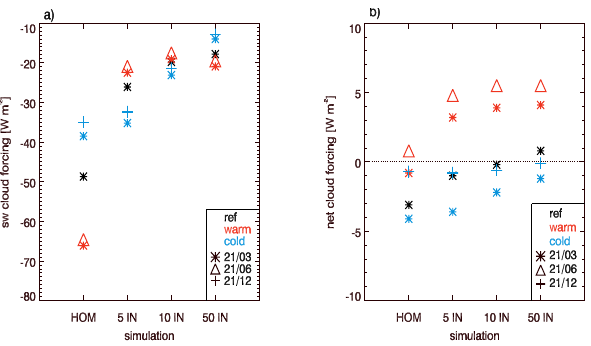
Figure 11. Averaged shortwave cloud forcing (a) and net cloud forcing (b) for the simulations HOM, 5 IN, 10 IN and 50 IN. Black, red and blue asterisks show the results for the reference, warm and cold temperature profiles for 06:00–12:00LT for the simulation where the IN freeze at RHi het = 130% and the solar zenith angle is representative of 21 March. Additionally, the results where the solar zenith angel is representative of 21 June (21 December) are shown for the warm (cold) profile for 06:00–12:00LT (red triangles, blue crosses) and RHi het = 130%. For the calculation of the mean, only values where τ > 0 . 03 are